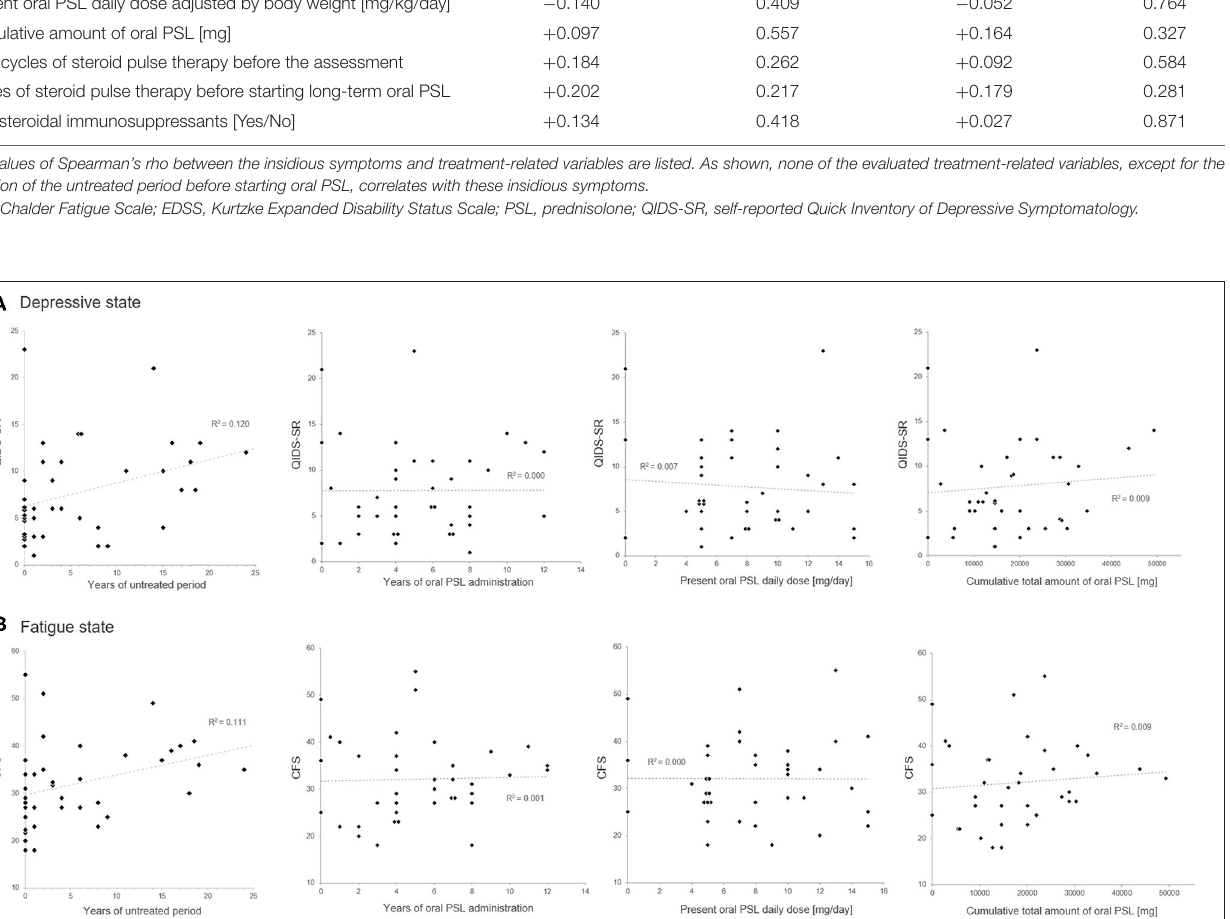
Frontiers in Neurology |